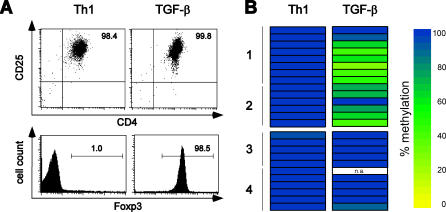
TGF-β–Induced Tregs Harbor Partially Demethylated CpG Motifs within the foxp3 Locus(A) CD25−CD4+ T cells sorted from spleens and LNs pooled from 20 male BALB/c mice were cultured for 6 d in the presence of TGF-β. Cells cultured under Th1 conditions were used as control. Within the starting population, less than 1% of the cells were Foxp3+ (unpublished data). On day 6, cultured cells were sorted by FACS for CD25+ cells. FACS analysis shows the purity of sorted subsets (upper panel) and Foxp3 expression in gated CD25+ cells derived from indicated cultures (lower panel). Numbers display frequency of cells within indicated populations. The bars in the lower graphs indicate the marker gate for Foxp3+ cells. The vertical and horizontal lines in the upper graphs indicate the quadrant used to identify the CD4+CD25+/− subsets.(B) Methylation pattern of selected amplicons of the foxp3 locus in sorted CD25+ cells derived from indicated cultures. The methylation status of individual CpG motifs within the four amplicons is color coded as described in Figure 2. One representative experiment out of two individual experiments is shown. n.a., not analyzed.